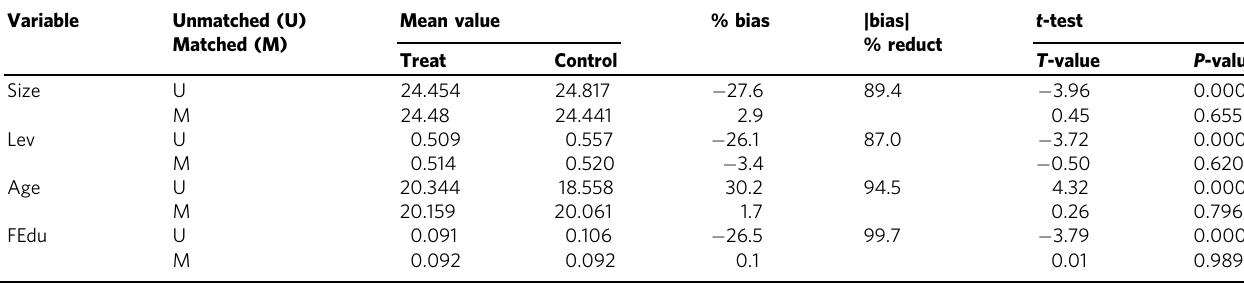
Table 10 PSM equilibrium test